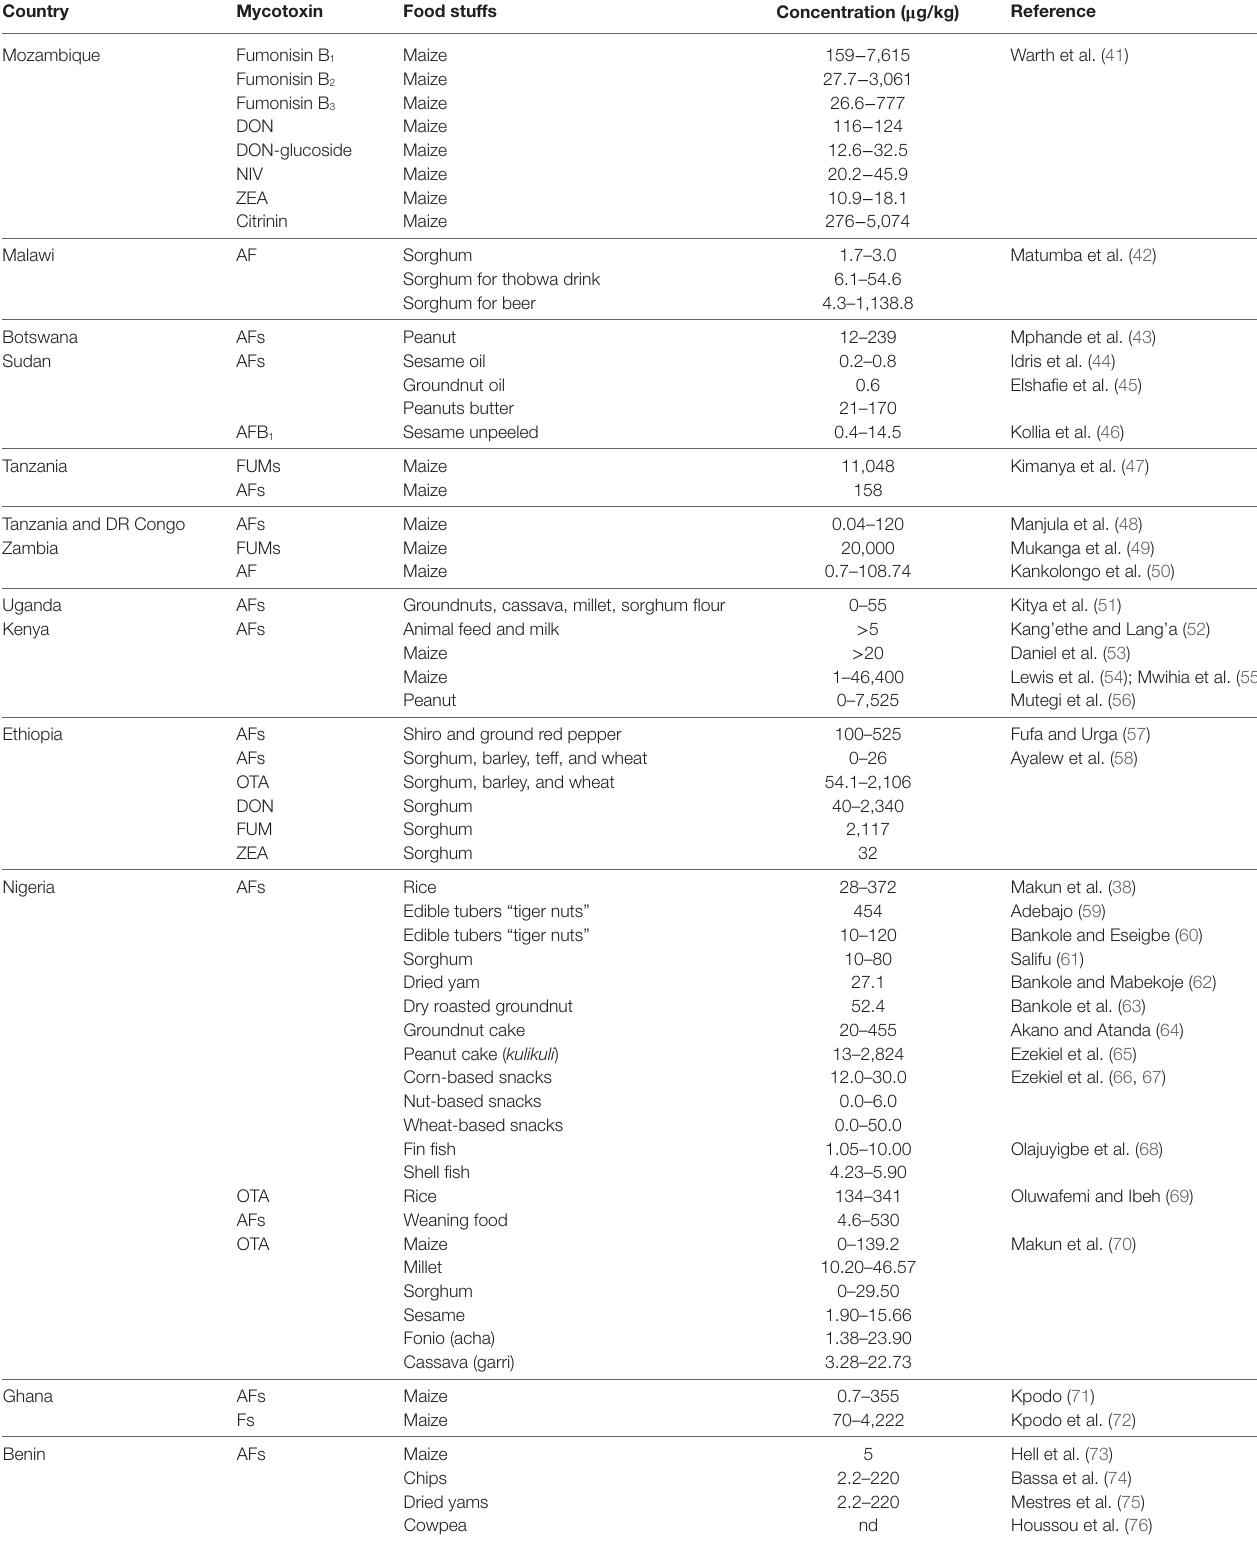
TABLe 1 | Mycotoxins levels ( μ g/kg) in the crops and foods in some African countries.